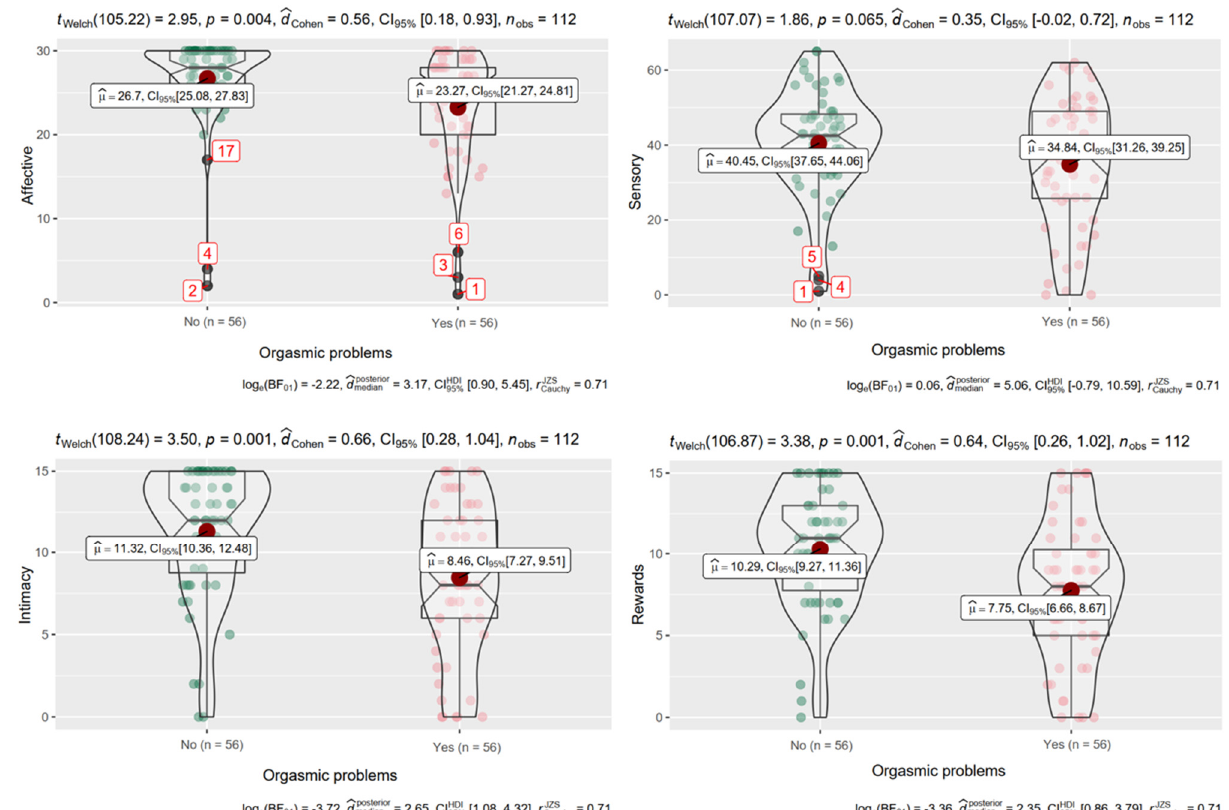
Figure 1. Distribution of data, for each of the four dimensions of the ORS, in the group with and without orgasmic problems. Note. Red dot indicates the population mean ( µ ) of that group. Bayesian results for the differences are shown below each figure.